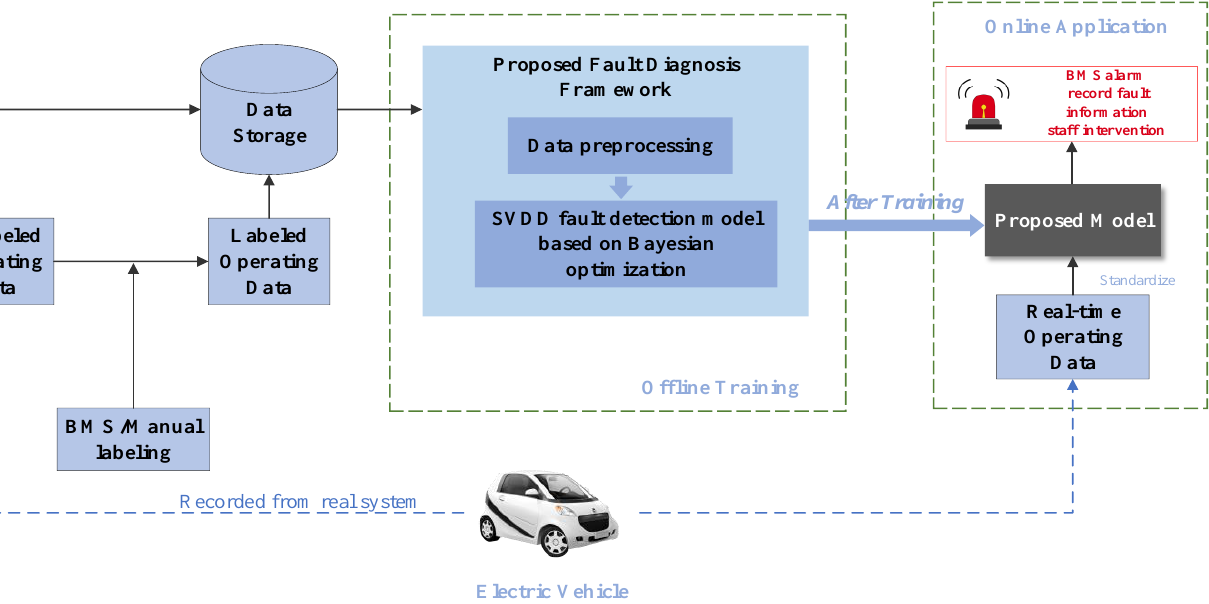
Figure 8. Application of the proposed model in a real electric vehicle.